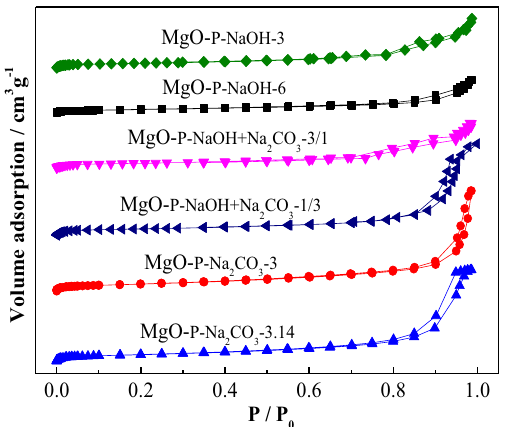
Figure 7. Nitrogen adsorption–desorption isotherms of different MgO catalysts.